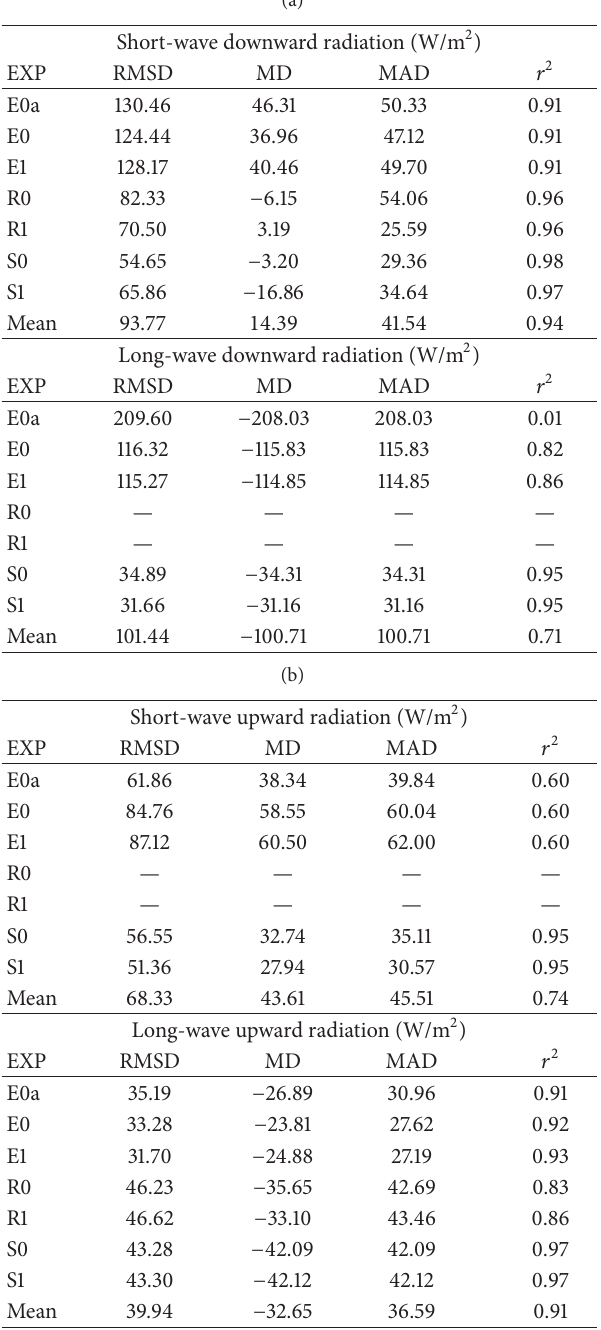
Table 6: Overview of the performance in simulating downward (a) and upward (b) short-wave and long-wave radiation on 7, 23, 2013. For further explanations refer to Table 5.